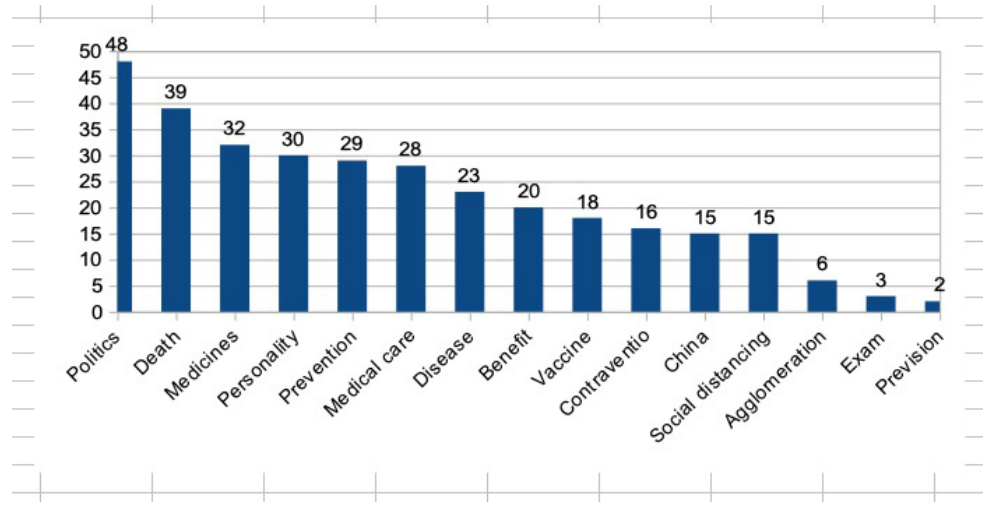
Figure 2. Frequency of themes in Lupa Source: elaborated by the authors based on raw numbers. Death, totaling 39, has 8 (20.51%) false allegations that living people were being buried or that coffins were being buried empty; in addition to these cases, we highlight three fake news articles about business suicides. These lies sought, above all, to reinforce the false dichotomy between health and economy, raised by some politicians and busi- nessmen during the pandemic.